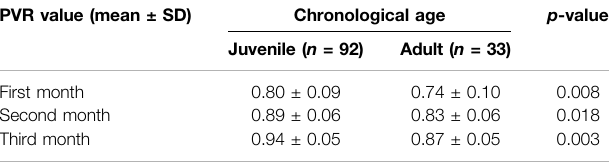
TABLE 3 | Subgroup analysis for the early PVR based on chronological age.